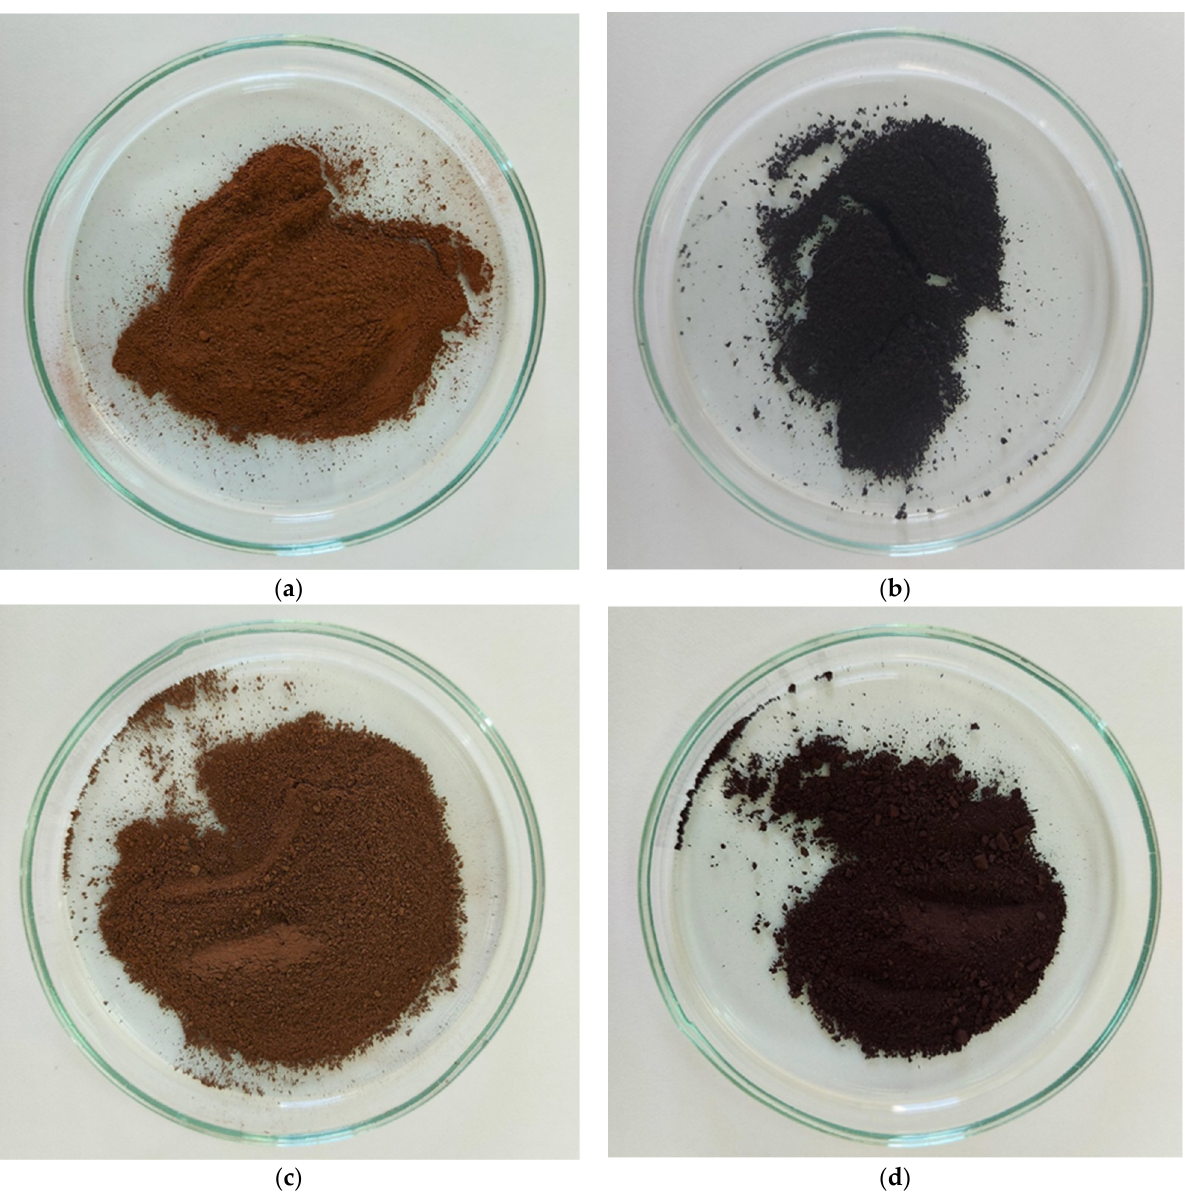
Figure 1. Photographs of ( a ) the solid [Fe(NH 2 CONH 2 ) 6 ]Cl 3 and [Cr(NH 2 CONH 2 ) 6 ]Cl 3 mixture, ( b ) CrFeO 3 composite generated using CrCl 3 slat after thermal decomposition at 800 ◦ C (Composite A ), ( c ) the solid [Fe(NH 2 CONH 2 ) 6 ]Cl 3 and [Cr(NH 2 CONH 2 ) 6 ](NO 3 ) 3 mixture, and ( d ) CrFeO 3 composite generated using Cr(NO 3 ) 3 · 9H 2 O slat after thermal decomposition at 800 ◦ C (Composite B